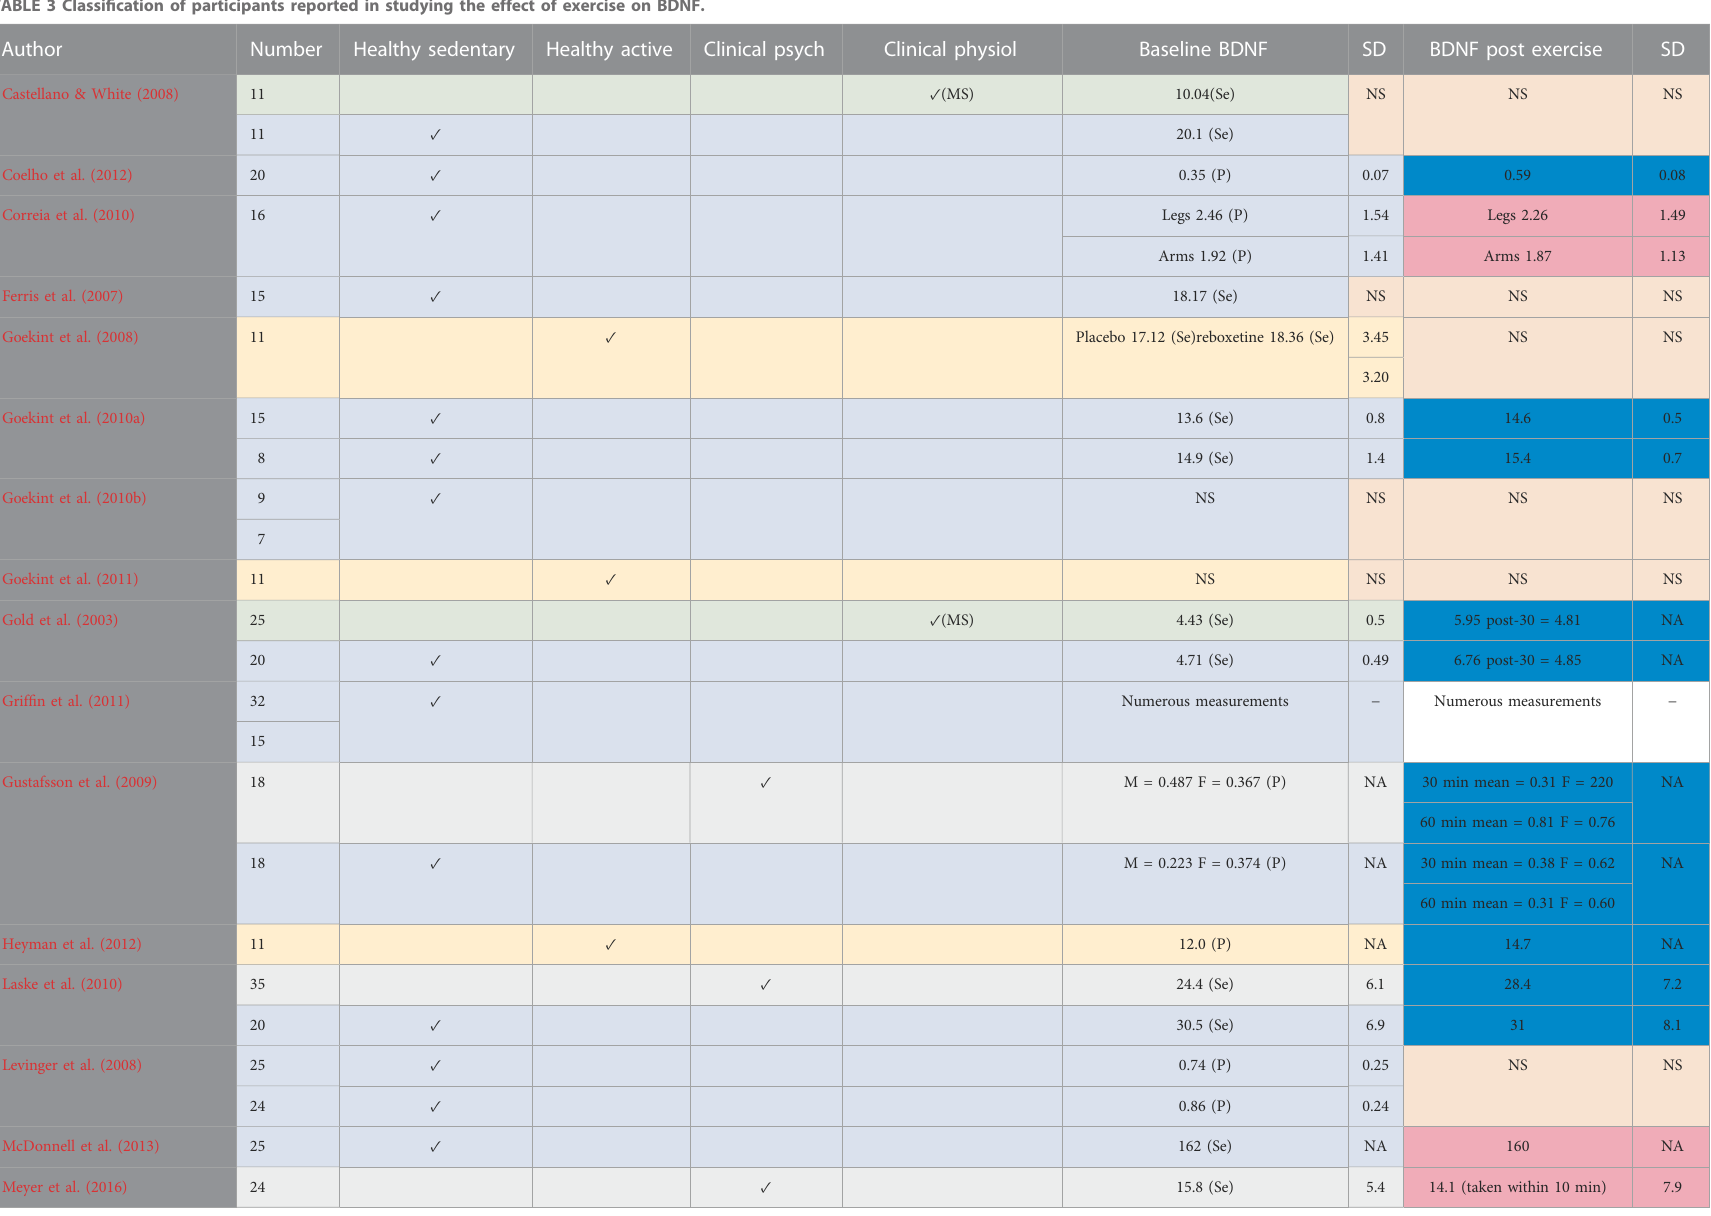
TABLE 3 Classi fi cation of participants reported in studying the effect of exercise on